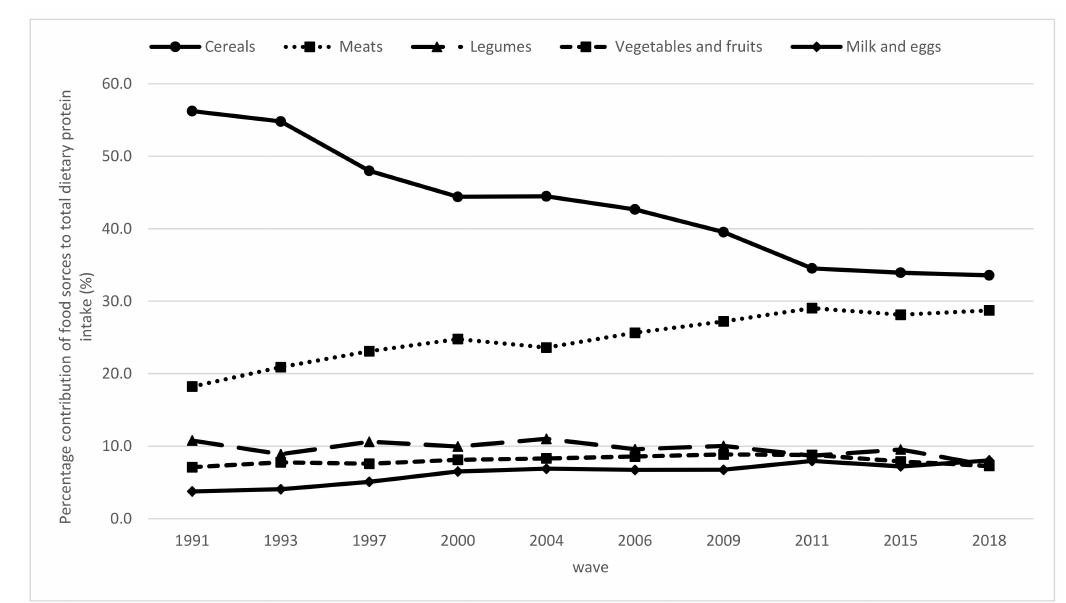
Figure 1. Trends in percentage contribution of food sources to total dietary protein intake among the elderly Chinese by wave from 1991 to 2018 ( p < 0.05 for the trend for all).